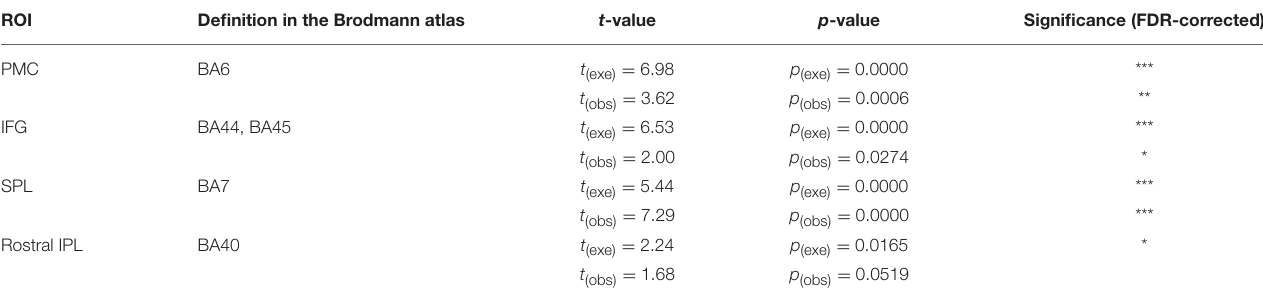
TABLE 2 | Activation when using the ROI-based group analysis. ROI Definition in the Brodmann atlas t -value p -value Significance (FDR-corrected) PMC BA6 t (exe) = 6.98 p (exe) = 0.0000 *** t (obs) = 3.62 p (obs) = 0.0006 ** IFG BA44, BA45 t (exe) = 6.53 p (exe) = 0.0000 *** t (obs) = 2.00 p (obs) = 0.0274 * SPL BA7 t (exe) = 5.44 p (exe) = 0.0000 *** t (obs) = 7.29 p (obs) = 0.0000 *** Rostral IPL BA40 t (exe) =